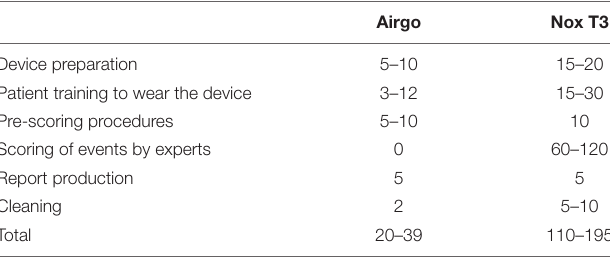
TABLE 5 | Comparison of time spent on the standard procedures to record sleep studies and produce a final